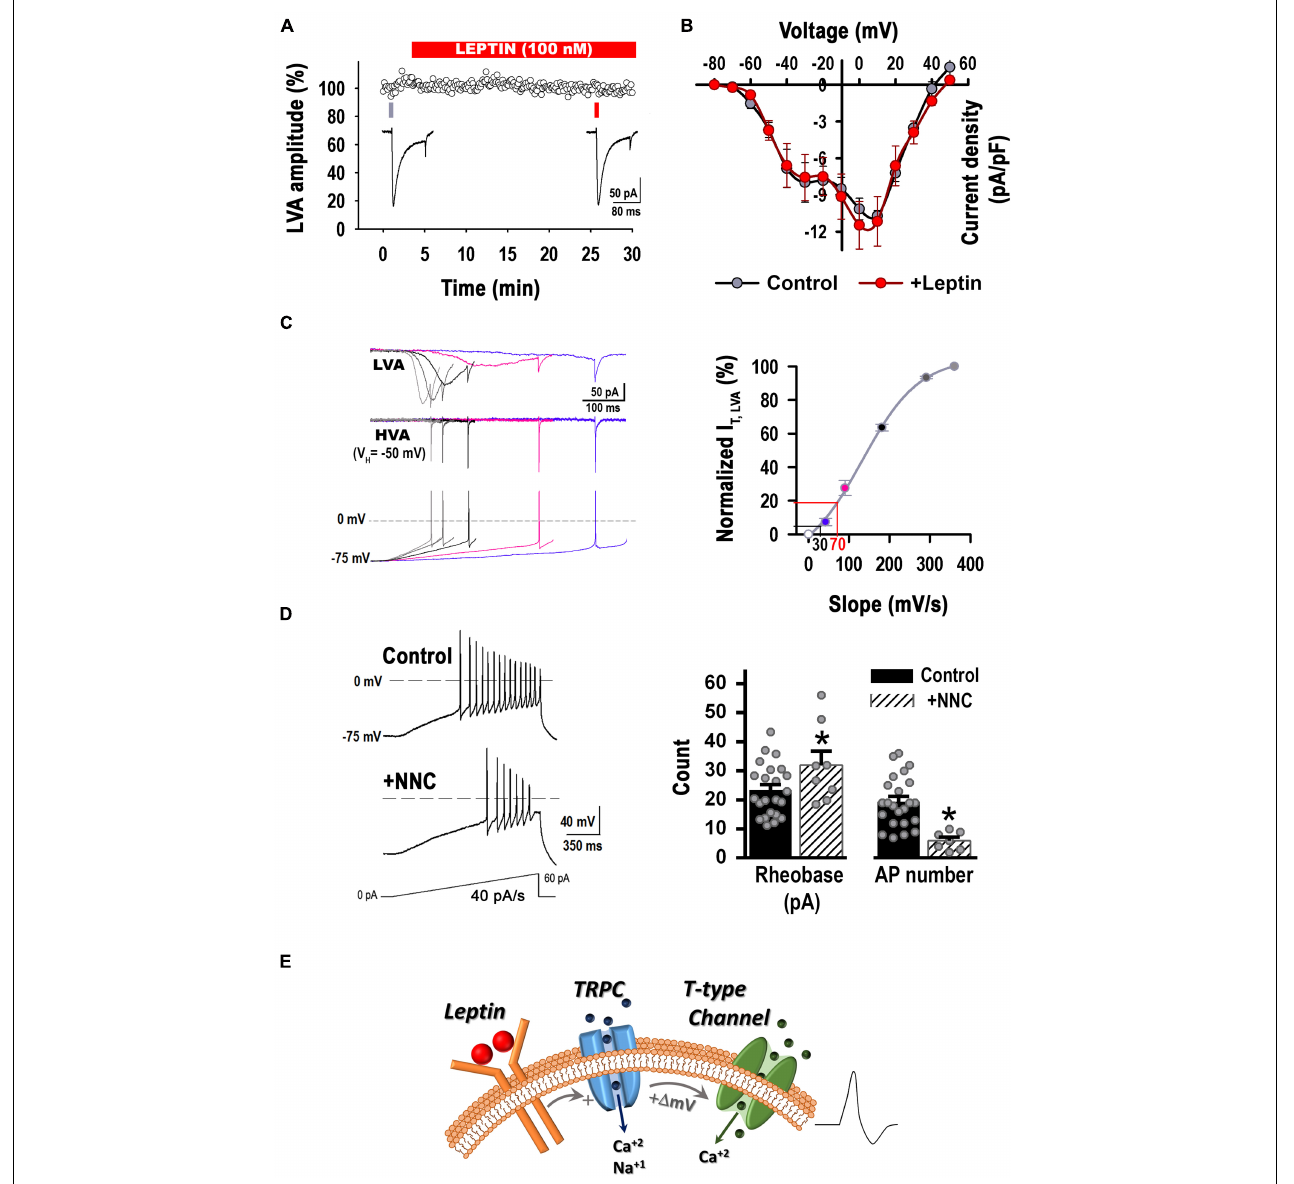
FIGURE 5 | Leptin has no direct effect on T-type current density but increases the membrane depolarization rate favoring T-type channels recruitment. (A) Acute incubation with Lep (100 nM) does not alter T-type currents (i.e., LVA currents) elicited by a step voltage from –90 to –30 mV ( n = 3). (B) I-V curves before and after the application of 100 nM leptin in the recording chamber ( n = 8, paired experiments). Currents were elicited by depolarizing voltage steps ( (cid:49) V = 10 mV) from a V H of –90 to 50 mV. There is not a statistically significant difference before and after the addition of leptin [ P > 0.05, Two Way RM ANOVA, F ( 1 , 55 ) = 0.221]. There is not a statistically significant interaction between the voltage and the treatment [ P > 0.05, Two Way RM ANOVA, F ( 11 , 55 ) = 0.785]. I-V curves from neurons that expressed LVA current at low and high levels were pooled. (C) Left: Average traces of T-type currents elicited by various rates of voltage depolarization preceding the first AP. Stimulation protocols (bottom traces) were obtained from hypothalamic neurons recorded in current clamp configuration during current ramp stimulations (20–100 pA/s), which resulted in the following rates of membrane potential depolarization prior the first AP: 40, 90, 180, 290 or 360 mV/s (V H = –75 mV). Before stimulation, the membrane potential was held at –90 or –50 mV (V H ) in order to isolate T-type currents. HVA currents recorded from a V H of –50 mV (middle traces) were subtracted from LVA and HVA currents recorded from a V H of –90 mV, obtaining the isolated LVA component (top traces). Right: Normalized T-type current as function of the membrane depolarization rate (slope) ( n = 5). The black line marks the percentage of non-inactivated T-type current recruited by a depolarizing rate of 30 mV/s. The red line marks the percentage of non-inactivated T-type current recruited by a depolarizing rate of 70 mV/s. (D) Left: Example of neuronal firing elicited from a preset membrane potential of –75 mV by a 40 pA/s ramp in a control neuron before and after the addition of the T-type channel blocker NNC 55-0396 (10 µ M). Right: Application of NNC 55-0396 ( n = 8) reduced membrane excitability in comparison to control ( n = 23) (–75 mV, 40 pA/s ramp). *Significantly different from control, P < 0.05, t -test. Rheobase: t = 2.060, df = 29. AP number: t = 3.956, df = 29. (E) Updated model of leptin’s cellular signaling. Leptin binding to its receptor results in activation of the PI3 kinase signaling pathway and subsequent activation of TRPC channel. TRPC channel activity induces a small but rapid